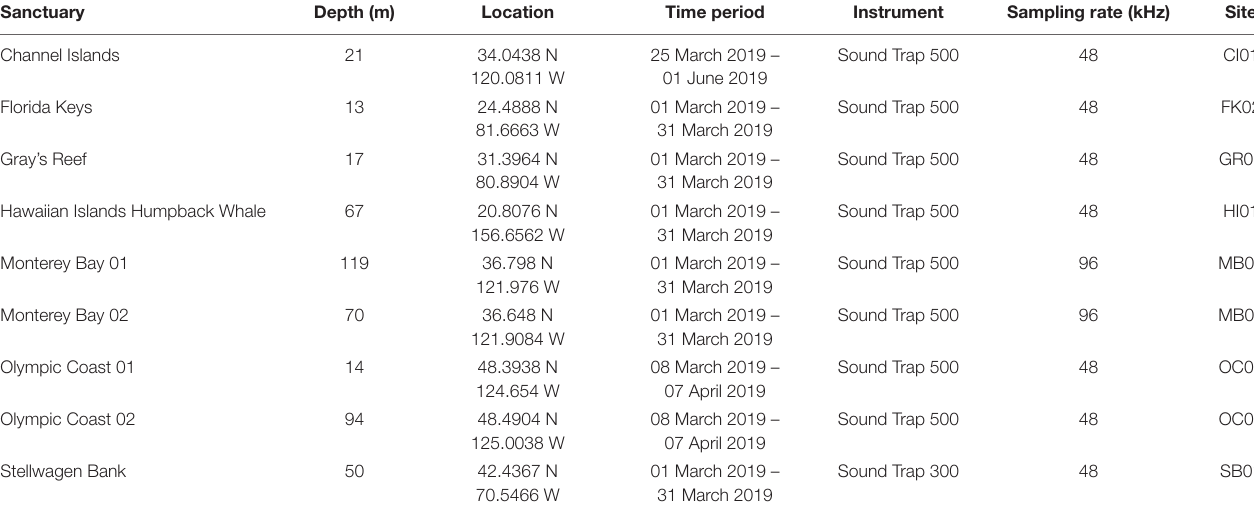
TABLE 1 | Summary of acoustic monitoring sites used for sound level comparisons. Sanctuary Depth (m) Location Time period